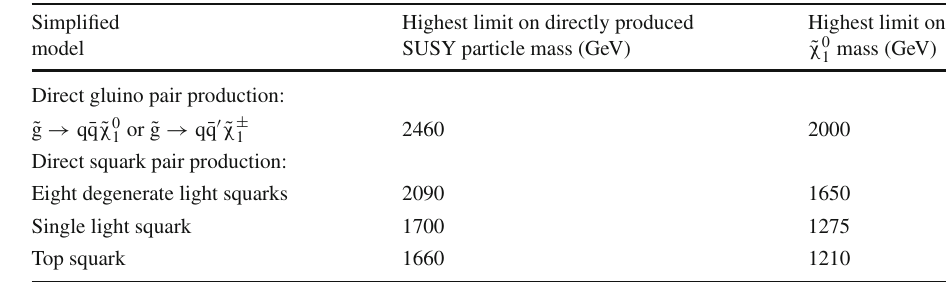
Table 10 Summary of the observed 95% CL exclusion limits on the masses of